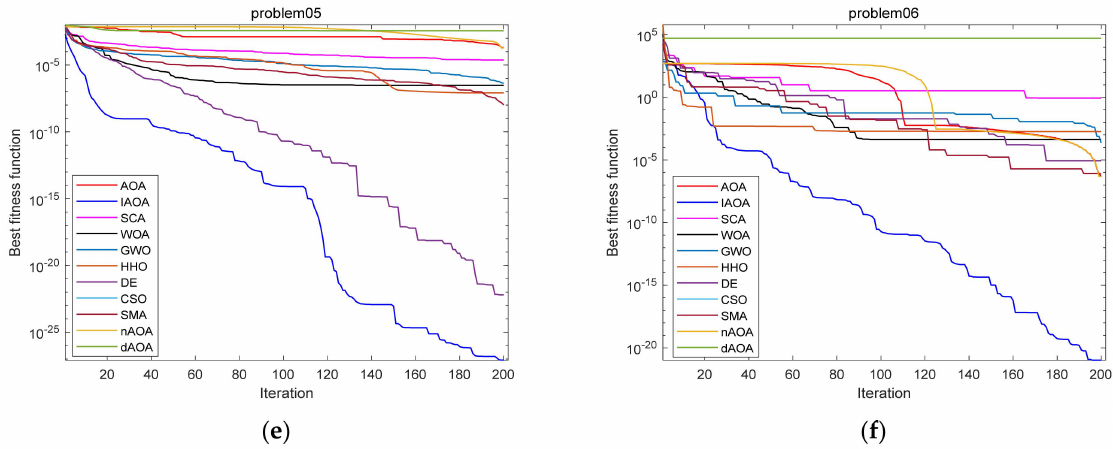
Figure 4. Convergence curve for tackling the NES (problem01–06 ( a – f